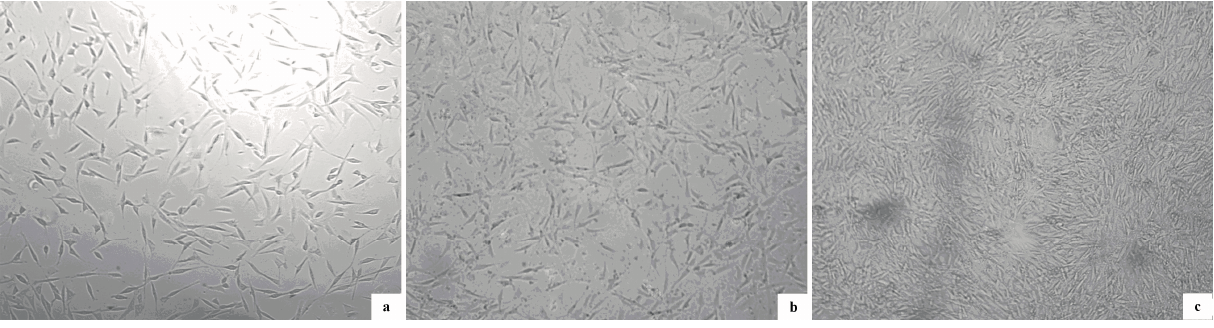
Figure 7. Optical micrographs (100×) of 3T3 fibroblasts cultured on ( a ) glass as control; ( b ) PLA; and ( c )